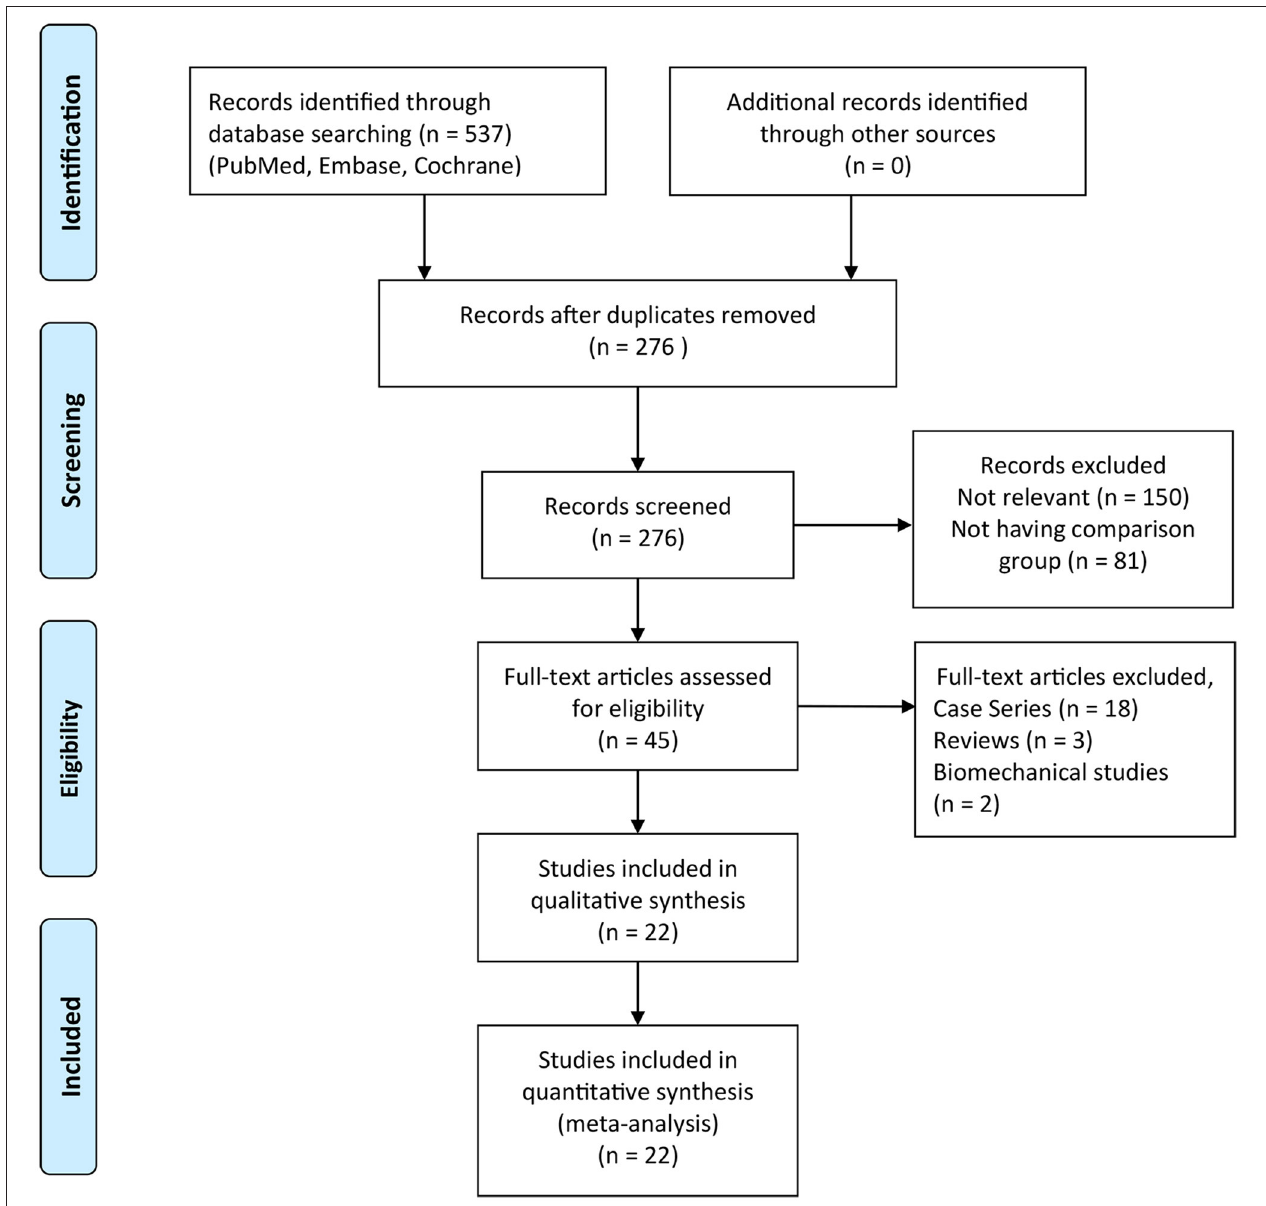
FIGURE 1 | Flow diagram of the study selection